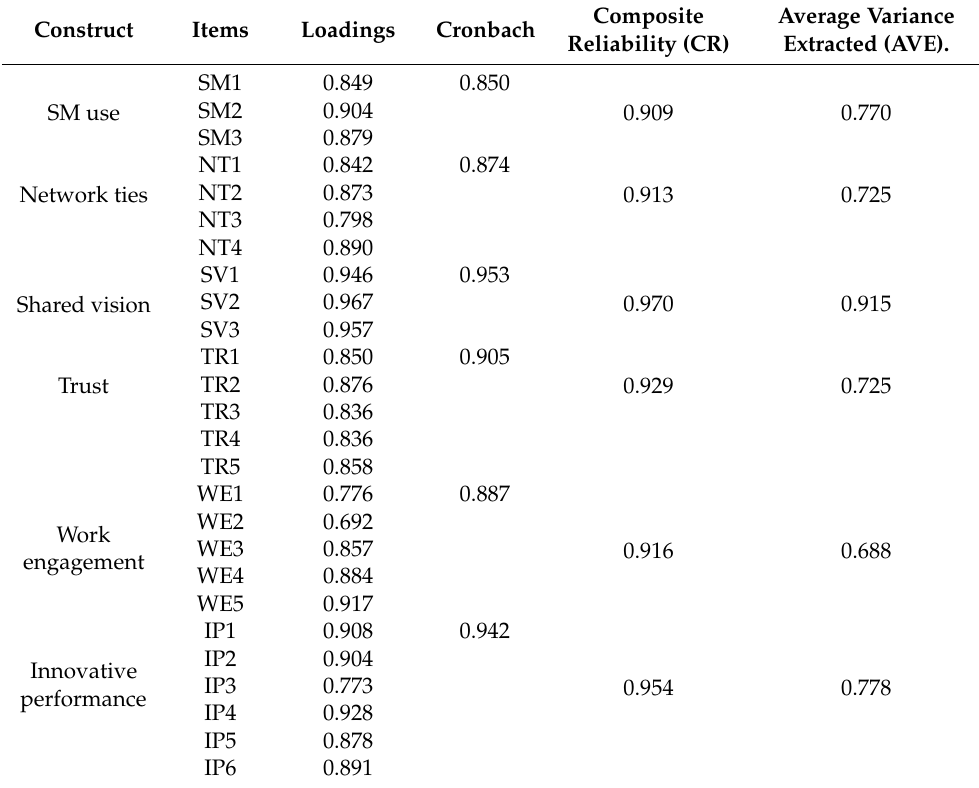
Table 4. Reliability and convergent validity